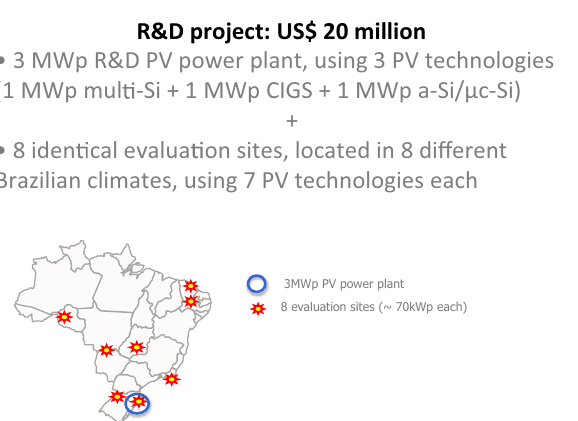
Fig. 1. General location in the Brazilian Territory of the eight identical Evaluation Sites (ES), located between 3 ° S and 28 ° S each with 70 kWp of PV using seven PV technologies, and the 3 MWp R&D PV power plant using three PV technologies.